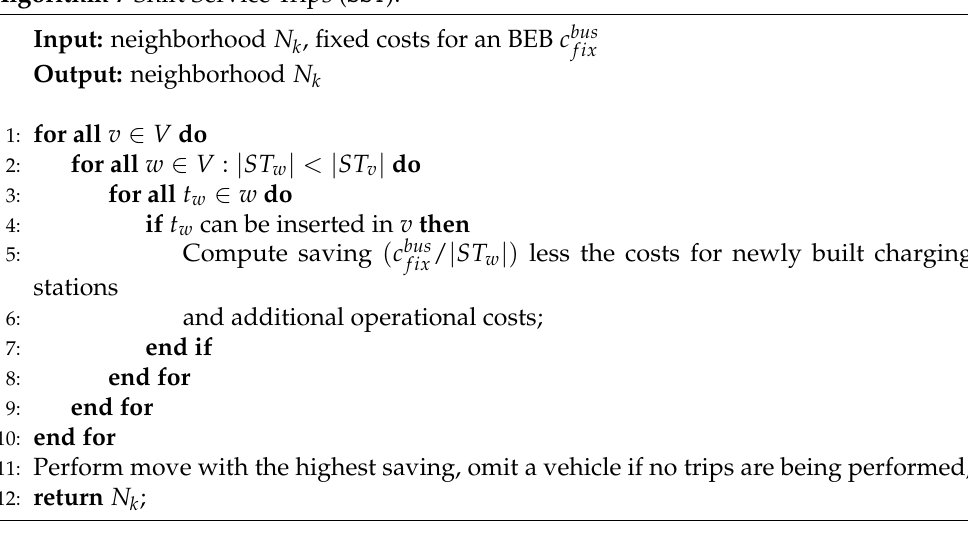
Algorithm 7 Shift Service Trips ( SST ).